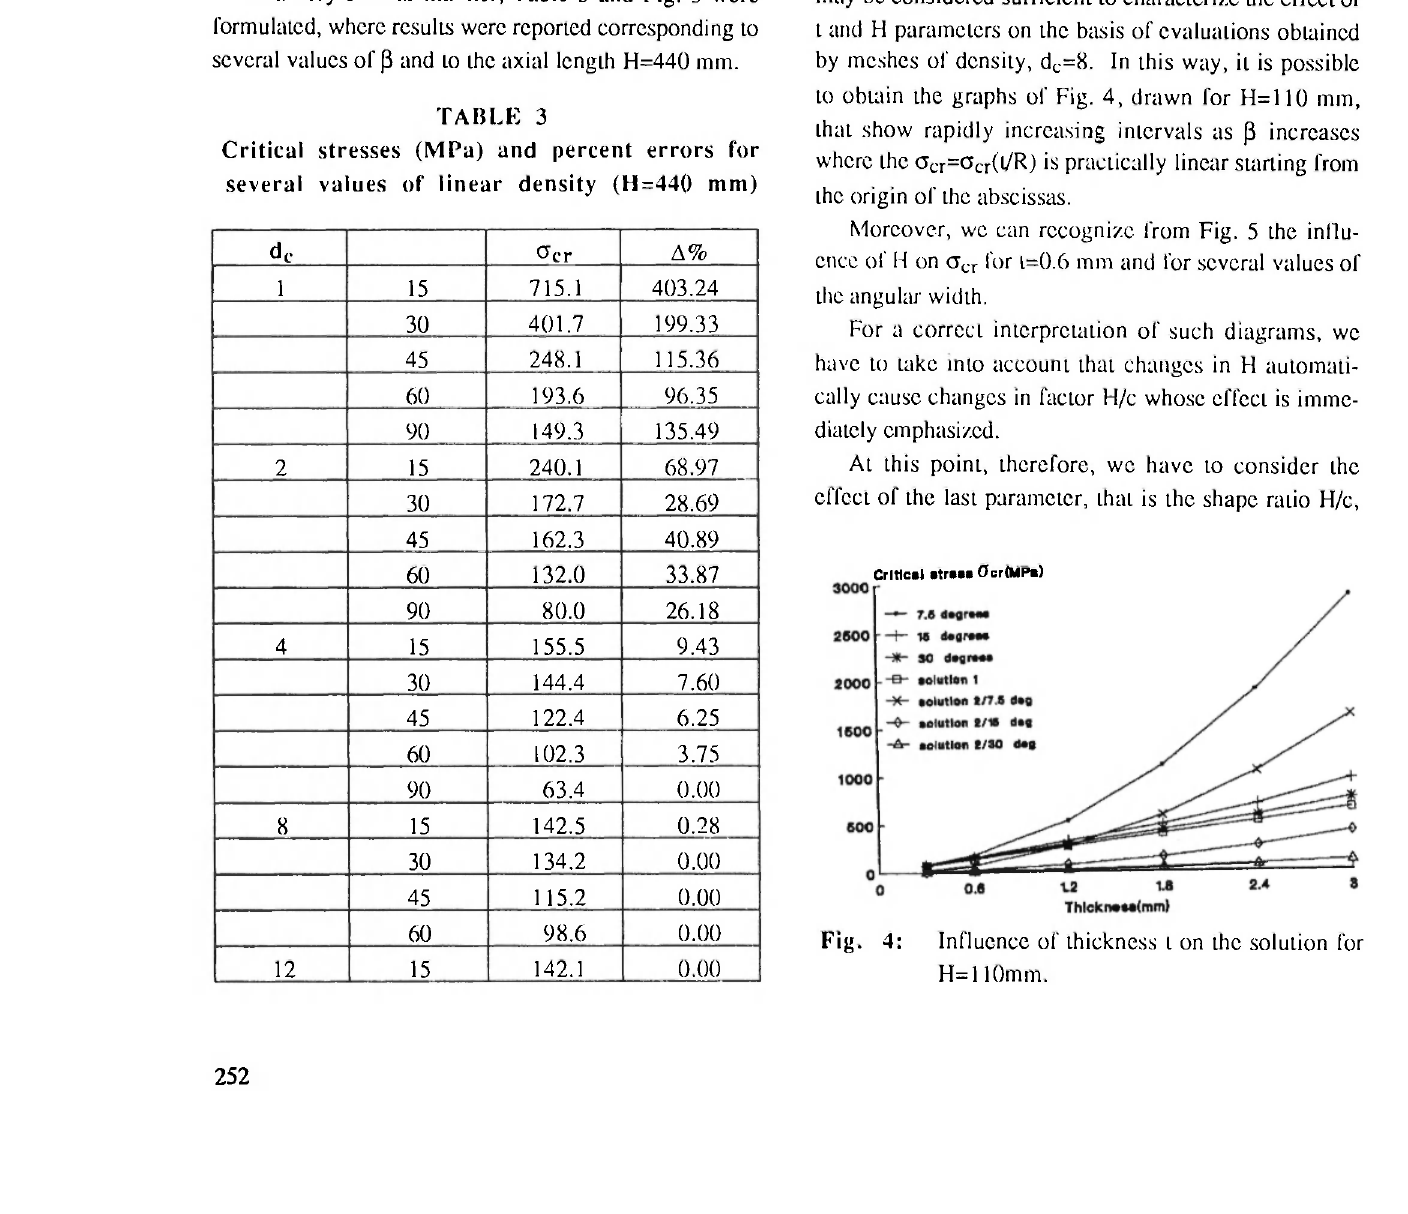
3: Influence of linear density d c on the solu- tion for H=440mm.